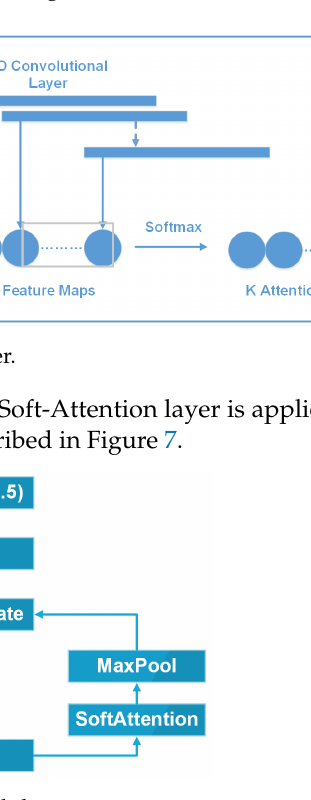
Figure 7. Soft-Attention